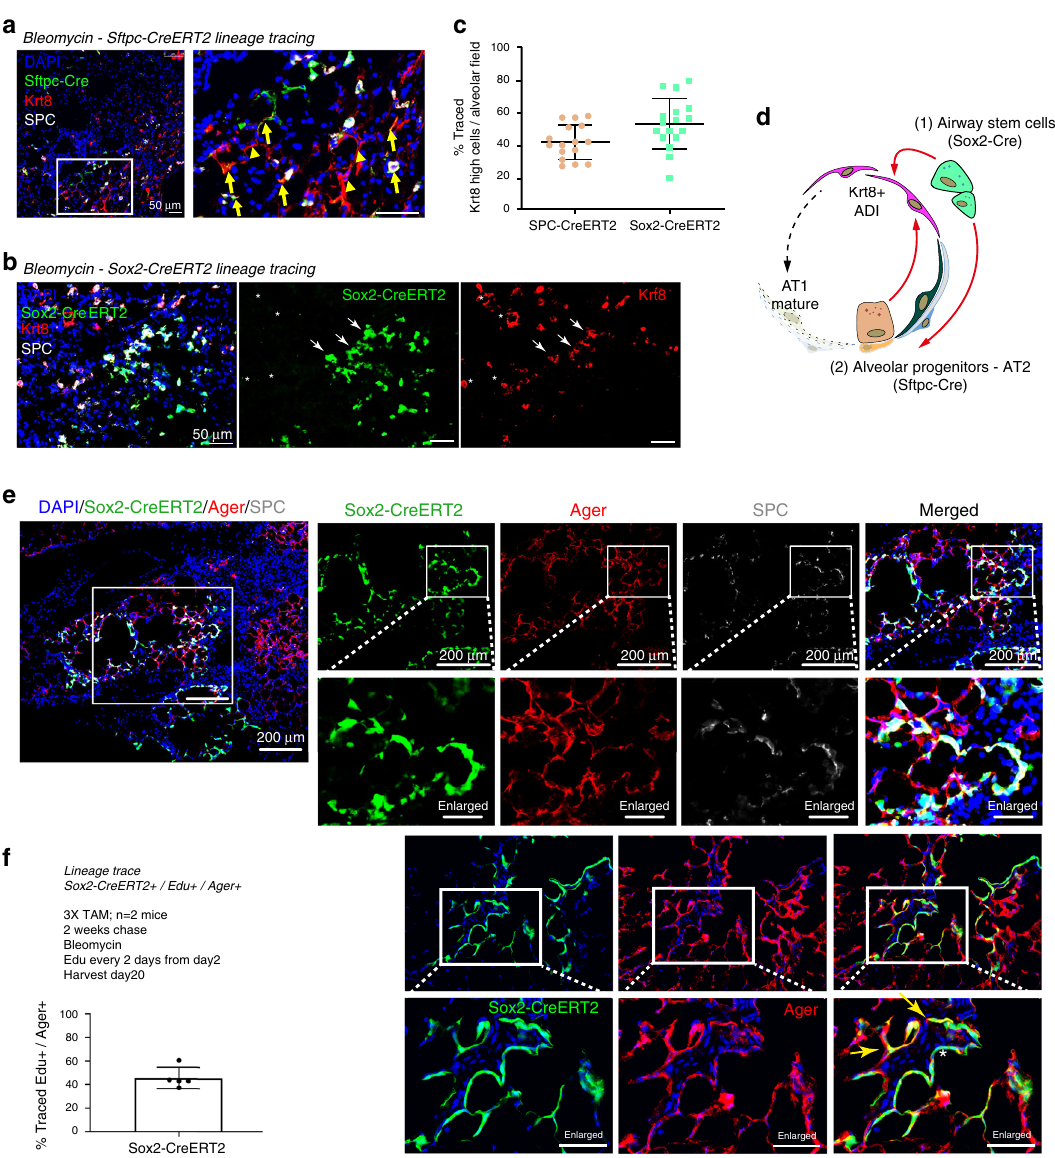
Fig. 7 Lineage tracing validates dual origin of Krt8+ADI. a , b Immunostainings of Krt8 and Sftpc (SPC) in ( a ) Sftpc-CreERT2-labeled mice ( n = 2) and b Sox2-CreERT2-labeled mice ( n = 2; lobes analyzed per mouse: n = 3). Arrows indicate lineage positive and stars lineage negative Krt8 + ADI. c Quanti fi cation of lineage labeled alveolar cells with high Krt8 expression. Each point in the graph represents a large region (at least 1.2 mm 2 area) and cells from at least three lobes/mouse at two different levels (>100 μ m apart) were analyzed in 16 fi elds of view (Sftpc-CreERT2: n cells = 1382; Sox2- CreERT2: n cells = 1833). d Lineage tracing experiments validate the scRNAseq experiments and show convergence of distinct alveolar progenitors into Krt8 + ADI. e Immunostainings of the AT1 marker Ager and the AT2 marker SPC with the Sox2-CreERT2 lineage label at day 14 after bleomycin. Heavily injured regions show only little endogenous SPC + cells but also Sox2-traced Ager + and SPC + cells. The experiment was performed on n = 2 mice and n = 3 lobes/mouse were analyzed. Flat lineage labeled cells can be observed Ager + (yellow arrow) and Ager − (asterisk). f Sox2-CreERT2 + /Ager + AT1 cells that previously proliferated upon bleomycin injury were quanti fi ed using the indicated EdU pulse chase labeling strategy. The percentage of EdU chased and lineage labeled AT1 cells is shown. Each dot represents cell counts from at least 2 large regions from two mice, n (mice) = 2; data represented with mean and